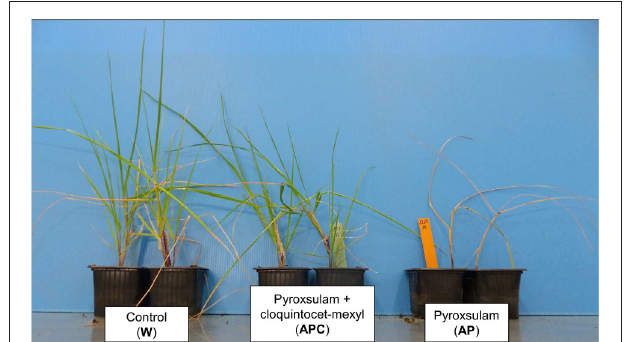
FIGURE 3 | Phenotypes of the clones of one rye-grass plant from population RG12-069 in the three experimental modalities used to assess the effect of the safener cloquintocet-mexyl on the sensitivity of individual rye-grass plants to pyroxsulam. The clones from this plant were rated sensitive (S) to pyroxsulam (AP) and resistant (R) to pyroxsulam associated to cloquintocet-mexyl (APC). W, water-sprayed